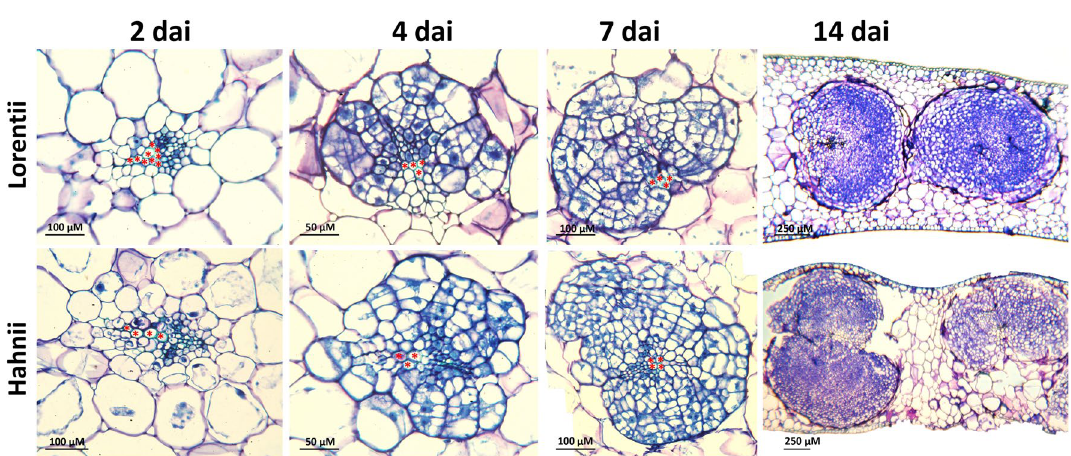
Figure 4. Time course of transdifferentiation events during in vitro callogenesis of Sansevieria trifasciata . Leaf explants cultured on 1X MS medium with 2 mg·Lˉ 1 2,4-D for callus induction were sampled, processed for microscopy, sectioned, and stained with a 1:1 1% methylene blue–1% azure B solution. Micrographs show high cell clusters surrounding ribbon fibers and vascular bundles. Asterisk = xylem cell. DAI = days after